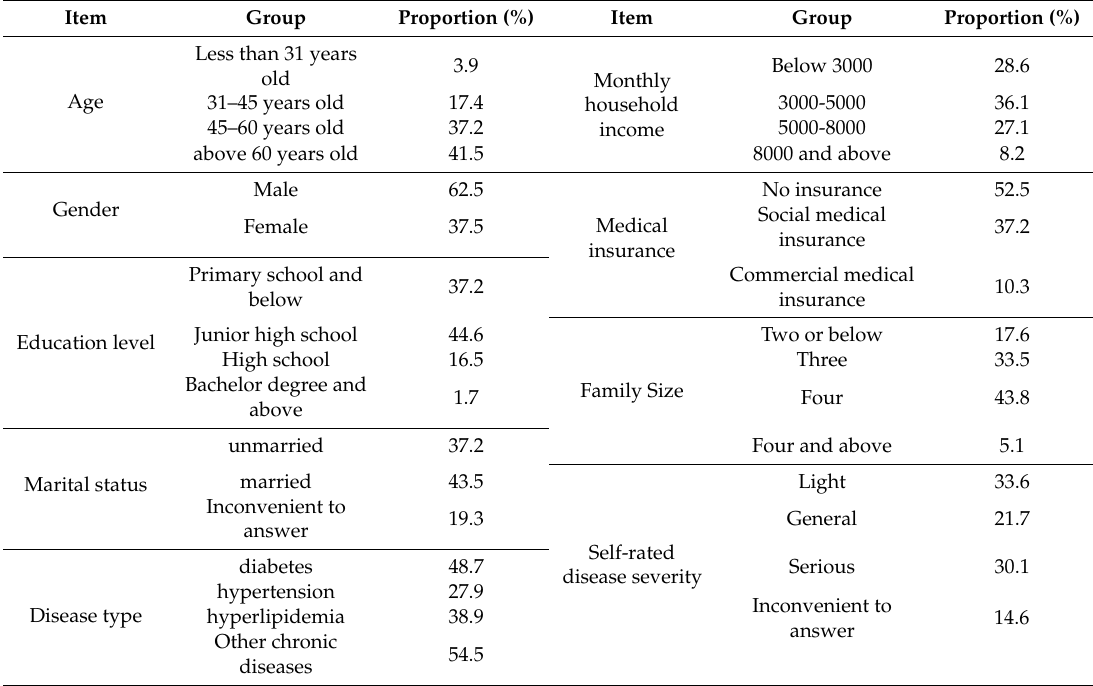
Table 1. Basic information of interviewees ( n =